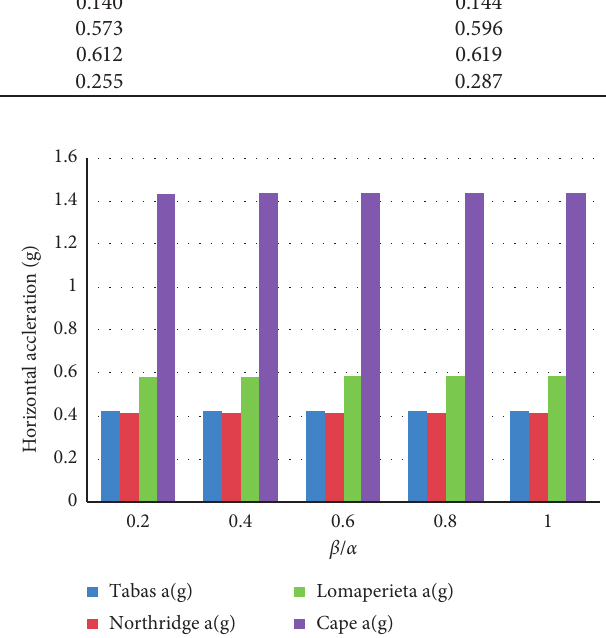
Figure 10: Maximum horizontal acceleration of tunnel lining at load combination 1 to 5.